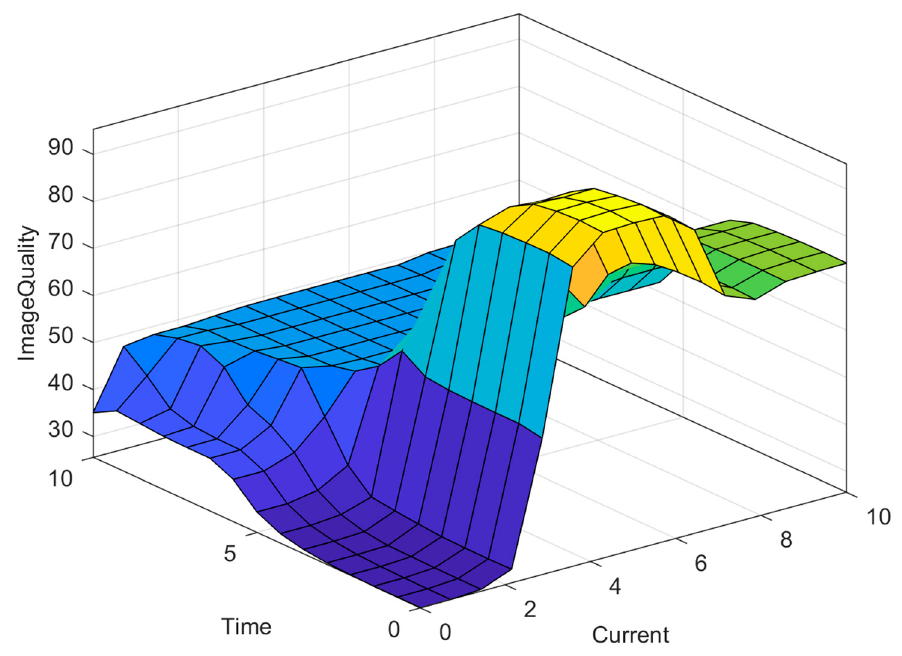
Figure 13. 3-D view of the model surface with respect to current intensity and time.